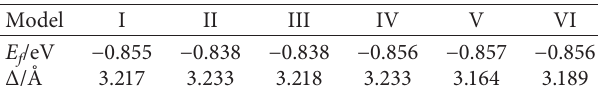
Figure 1: The lattice structure of GaSe/SiH vdW heterostructure: (a) model I, (b) model II, (c) model III, (d) model IV, (e) model V, and (f) model VI. The upper part is for top view, and the lower part is for side view. The Ga, Se, Si, and H atoms are represented by brown, yellow, golden yellow, and white balls, respectively. Table 1: The formation energy ( E f ) and interface distance ( Δ ) for the six stacking